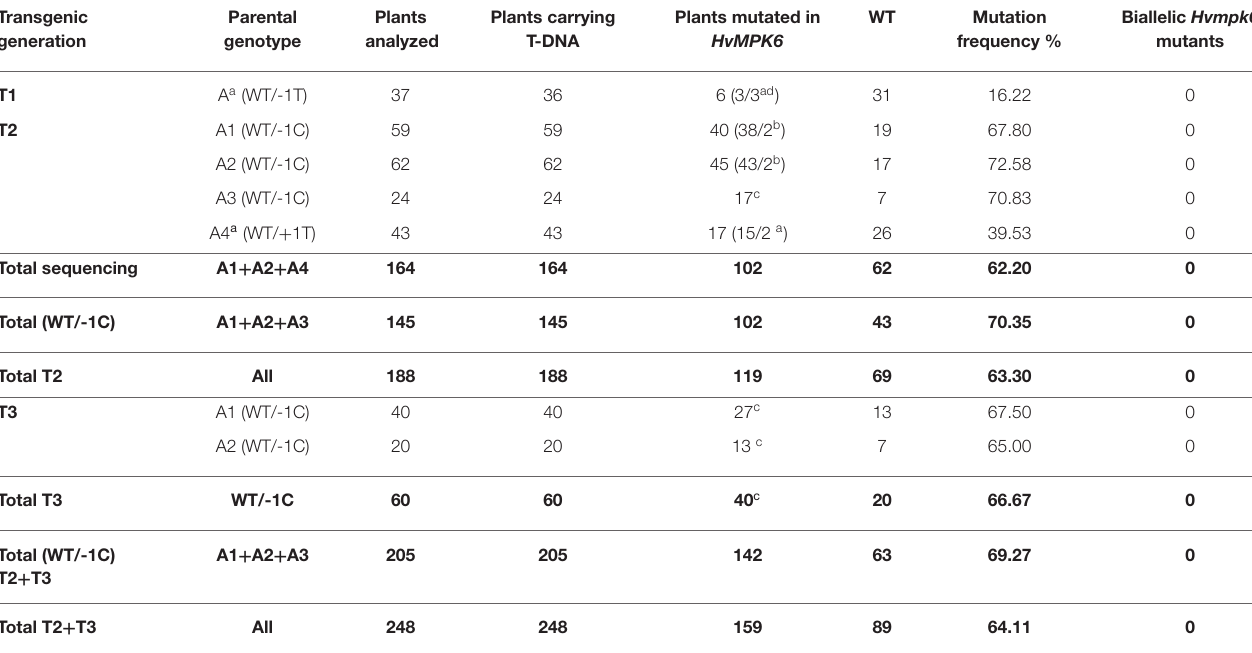
TABLE 3 | Detection of the on-target mutations and T-DNA in emerged plants in T1, T2, and T3 generation. Transgenic